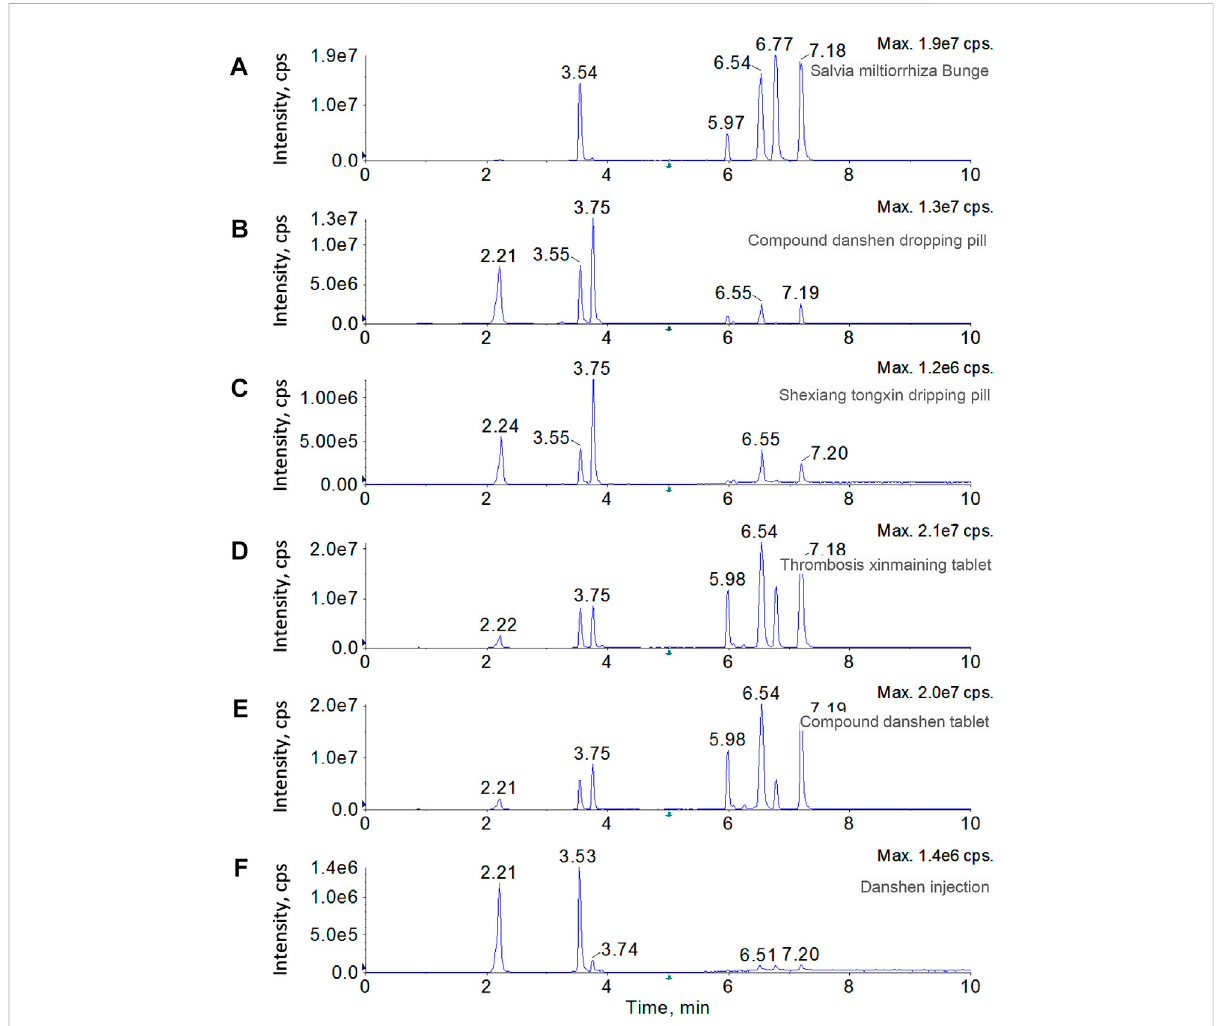
FIGURE 4 Chromatograms of SMB and fi ve SMB derived products, including SMB decoction pieces, compound danshen dropping pill, thrombosis xinmaining tablet, danshen injection, compound danshen tablet, and shexiang tongxin dripping